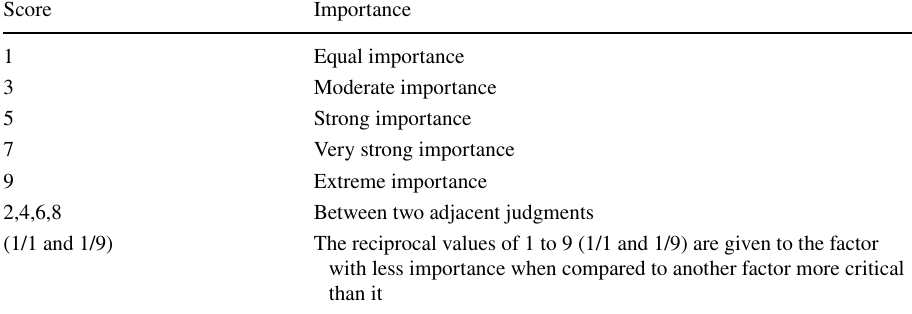
Table 2 The score of